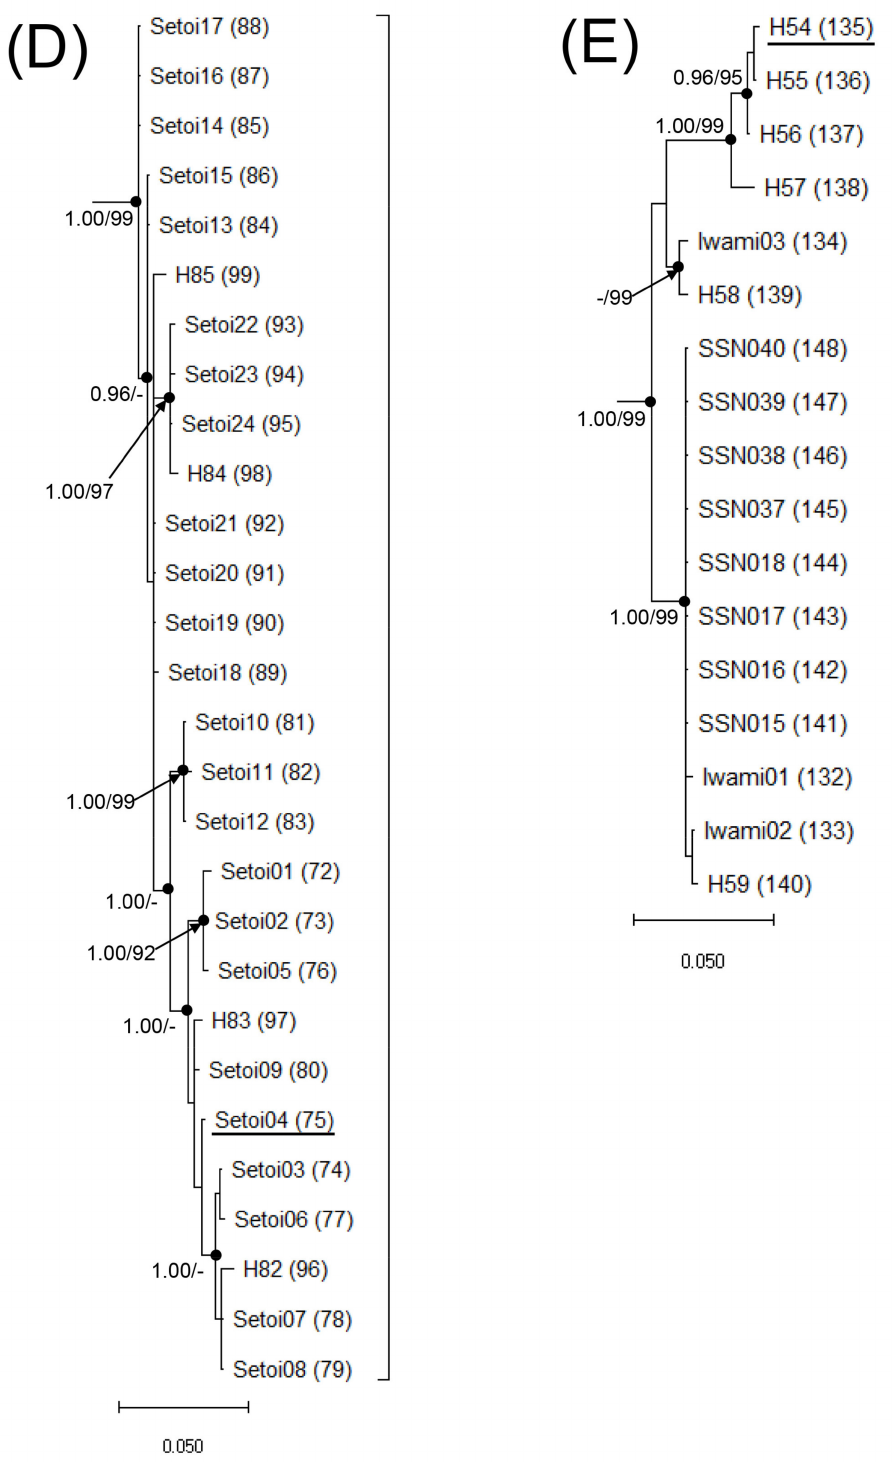
Figure 2. Bayesian inference phylogenetic tree based on 630-base pair (bp) cytochrome b sequences rooted with Salamandrella keyserlingii . Five phylogenies indicate that phylogenetic relationships of ( A ) all Japanese Hynobius species, ( B ) within H. kunibiki sp. nov., ( C ) within H. utunomiyaorum (also H. hidamontanus ), ( D ) within H. setoi , and ( E ) within H. iwami , respectively. Scale bars indicate the genetic distance (expected changes per site). Numbers near nodes indicate the supported level based on Bayesian posterior probabilities (BPP) and bootstrap values (BSV), respectively. Underlined labels indicate the type locality of the three species and H. iwami . Numbers appearing in parentheses after the labels correspond to population localities as indicated in Table S1 and Figure